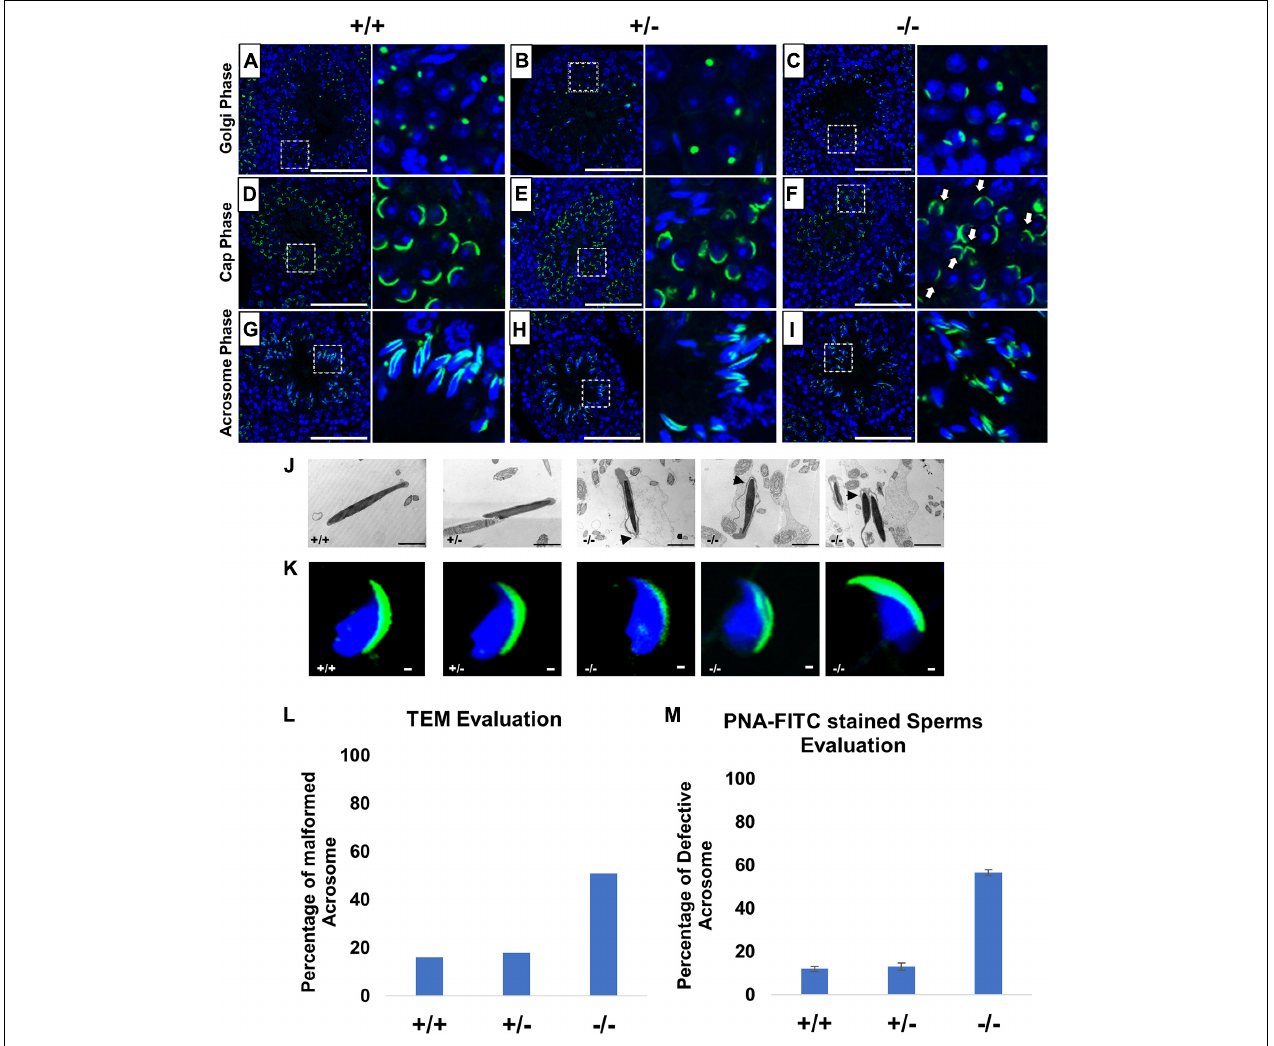
FIGURE 4 | Impaired acrosome biogenesis in Pfn3 -deficient mice. Adult testis sections of Pfn3 + / + (left panel), Pfn3 + / − (middle panel), and Pfn3 -deficient (right panel) mice; the developing acrosome was labeled with PNA-FITC (green) and cell nuclei were stained with DAPI (blue); inset panel showed the Golgi/cap/acrosomal phase of the tubules displayed in the main panel ( n = 3). In the Golgi phase, proacrosomal granule (green) labeled by PNA-FITC for (A) Pfn3 + / + , (B) Pfn3 + / − , and (C) Pfn3 − / − round spermatozoa. In the cap phase, acrosomal caps (green) stained for (D) Pfn3 + / + , (E) Pfn3 + / − , and (F) Pfn3 − / − round spermatozoa (white arrows show fragmented cap structures). In the acrosome phase, PNA-FITC-labeled acrosomal area on (G) Pfn3 + / + , (H) Pfn3 + / − , and (I) Pfn3 − / − elongated spermatids. Scale bar = 20 µ m. (J) Ultrastructure analysis using TEM revealed the acrosomal structures of Pfn3 + / + , Pfn3 + / − , and Pfn3 − / − sperm cells. Scale bar = 2 µ m. (K) Immunofluorescence staining using PNA-FITC (green) on epididymal sperm cells of Pfn3 + / + , Pfn3 + / − , and Pfn3 − / − mice ( n = 3). Scale bar = 20 µ m. (L) TEM evaluation shows the percentage of malformed acrosomes in Pfn3 + / + , Pfn3 + / − , and Pfn3 − / − sperm cells ( n = 2). (M) A graph represents the PNA-stained defective acrosome percentage of Pfn3 + / + , Pfn3 + / − , and Pfn3 − / − sperm cells ( n = 3). Two hundred spermatozoa were counted per